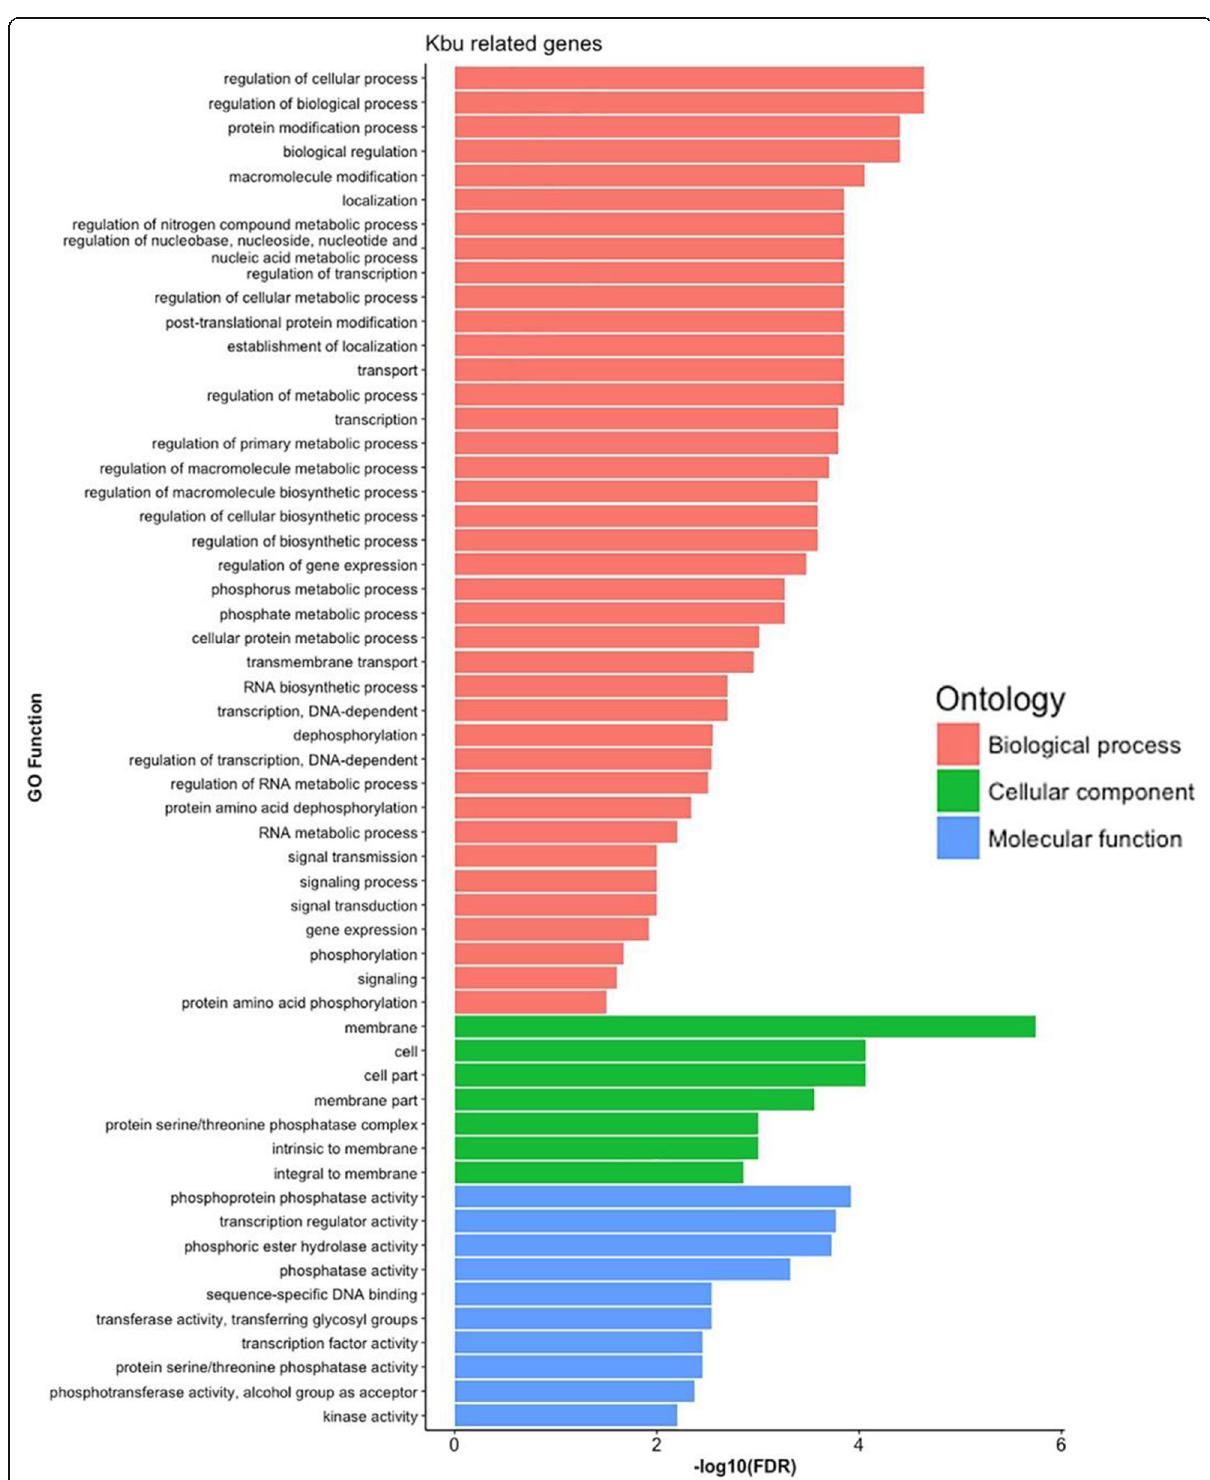
Fig. 7 Functional annotation of the lysine butyrylome. Representative GO annotations of histone Kbu sites for genes in the three primary GO categories “ biological process ” , “ molecular function ” , and “ cellular component ” . Gene ontology (GO) analysis was performed on 1480 genes that showed significant histone Kbu enrichment out of 14,808 Kbu-related genes in this